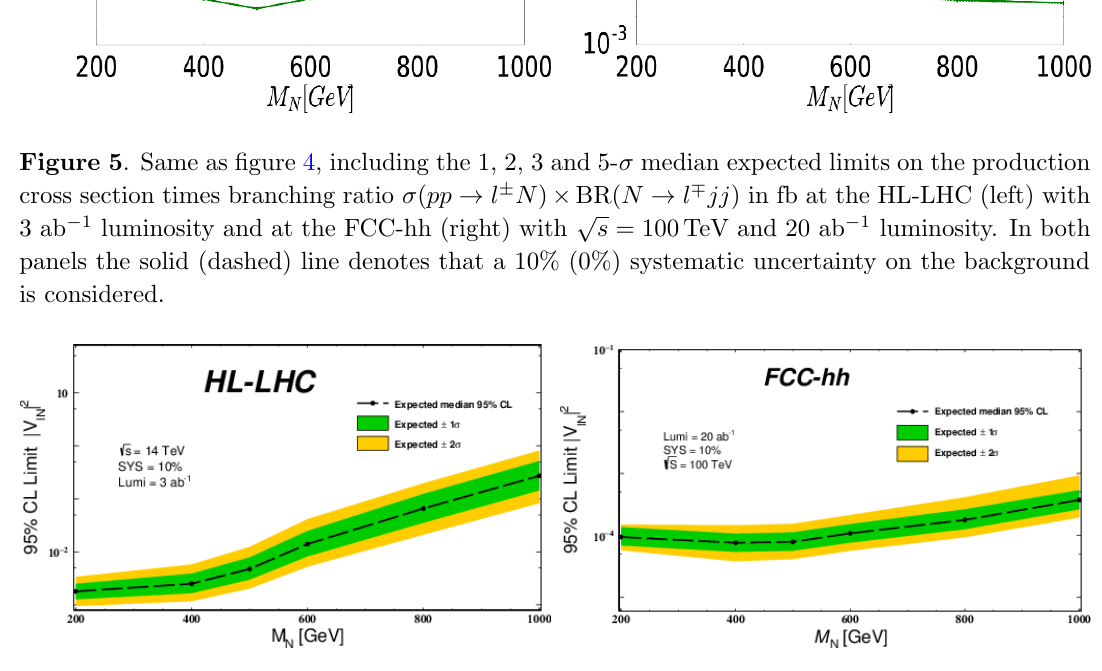
Figure 6 . Expected limits on the parameter j V lN j 2 when testing the signal hypothesis for j V lN j 2 = j V eN j 2 = j V (cid:22)N j 2 and j V (cid:28)N j 2 = 0, including the 1 and 2- (cid:27) con(cid:12)dence interval. The left (right) panel p denotes the limit for the HL-LHC (FCC-hh) with s = 14 (100) TeV and 3 (20) ab (cid:0) 1 luminosity. These limits have been derived based on the analysis of the e (cid:6) (cid:22) (cid:7) jj (cid:12)nal